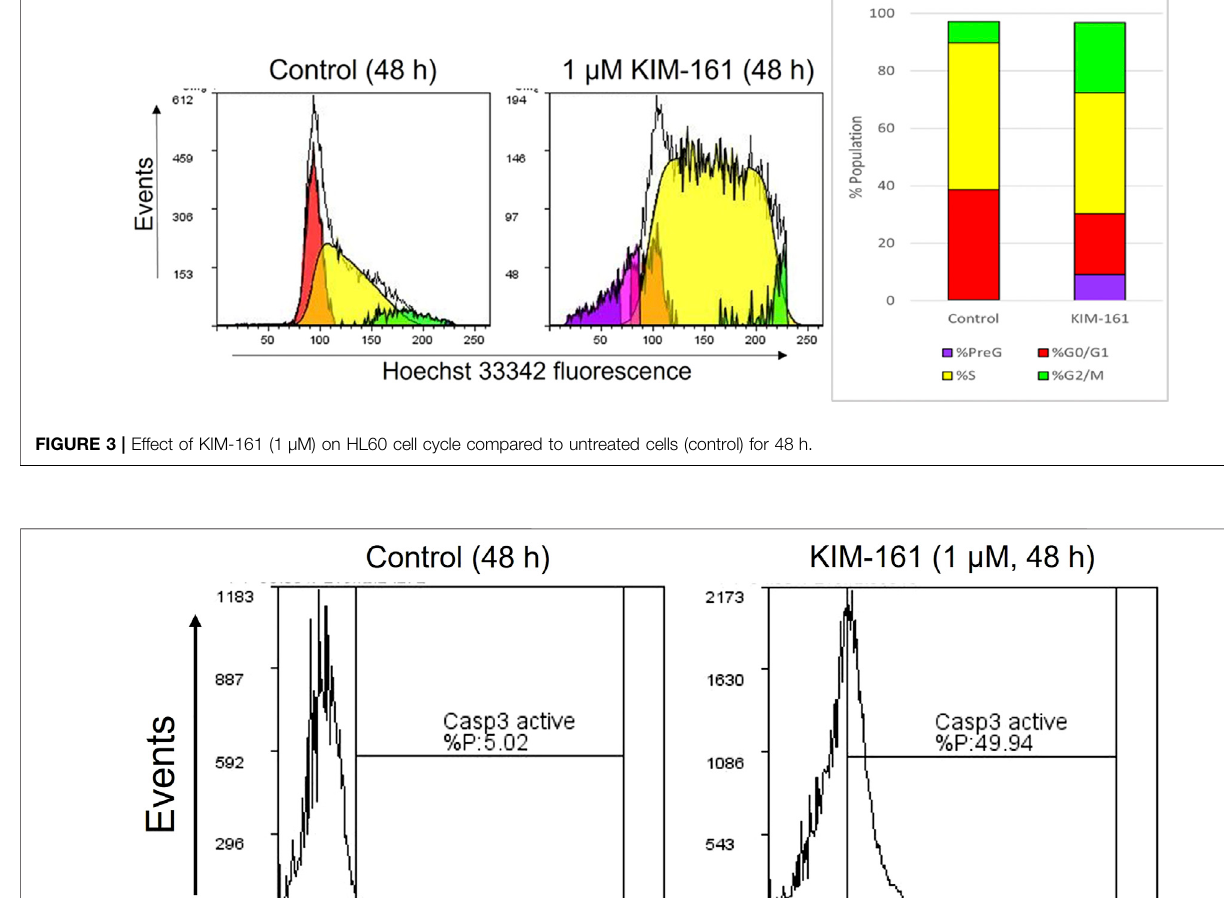
Frontiers in Pharmacology |